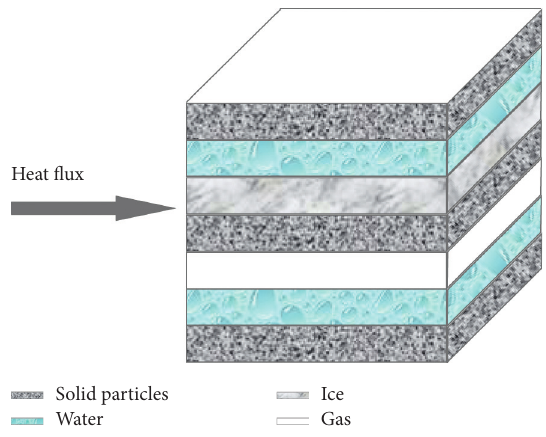
Figure 1: Parallel plate phase distribution in the series